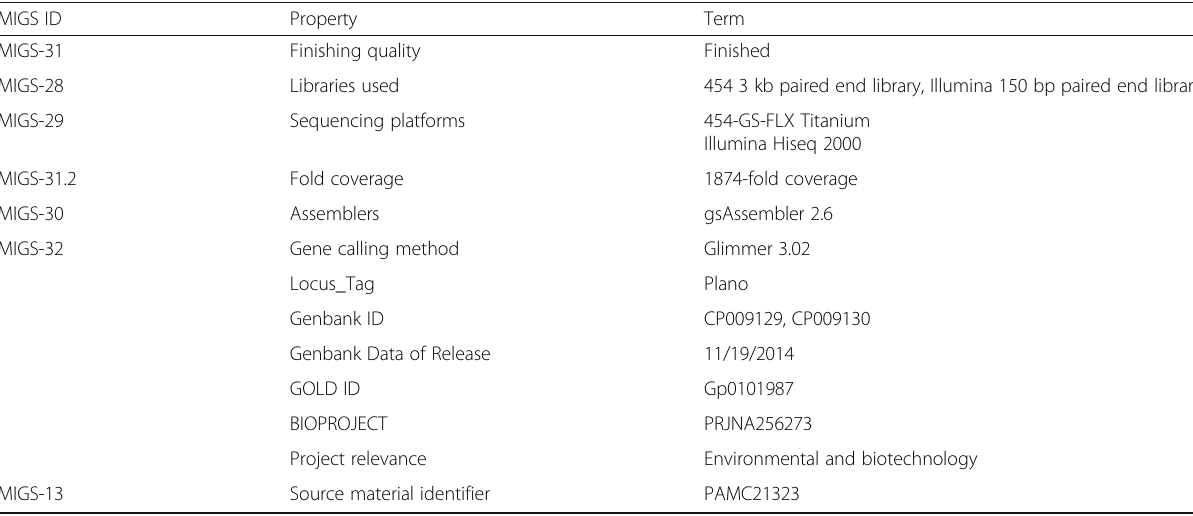
Table 2 Genome sequencing project